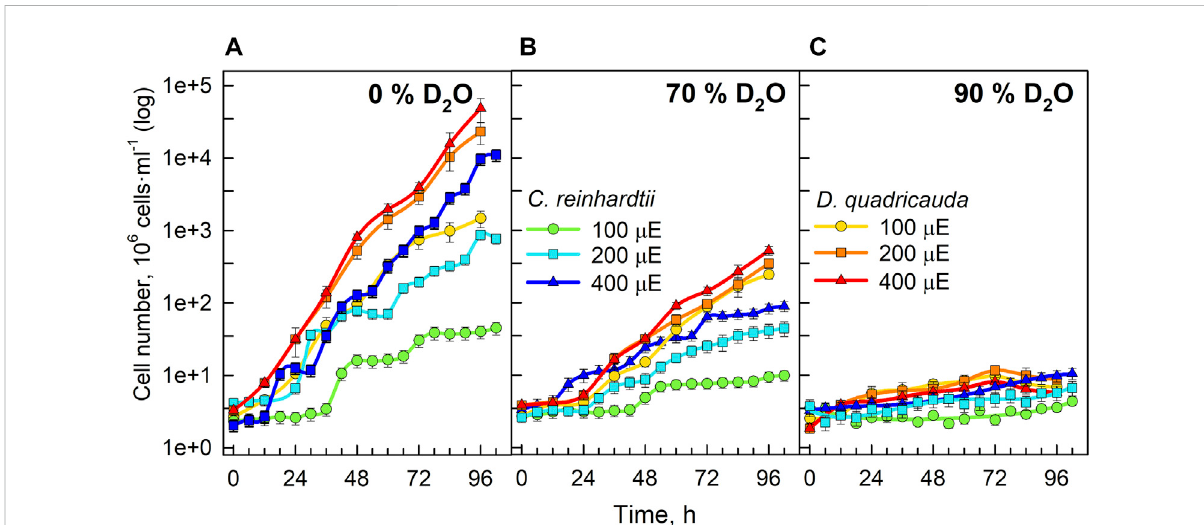
FIGURE 3 Cell numbers of cultures grown in 0% D 2 O (A) , 70% D 2 O (B) or 90% D 2 O (C) at three light intensities (100, 200, and 400 μ mol m − 2 s − 1 ) extrapolated from semi-batch cultivation mode. Light intensities are described in μ E (instead of μ mol photons · m − 2 · s − 1 ), in order to fi t the legends. Note the logarithmic scale on the Y axis. Although the cultures were regularly diluted to ensure a constant light supply (semi-batch cultivation), the values obtained were recalculated using individual dilution factors. Therefore, the graphs represent a projection of growth in semi-batch cultivation mode to continuous growth. In this way, the graphs are easier to read and